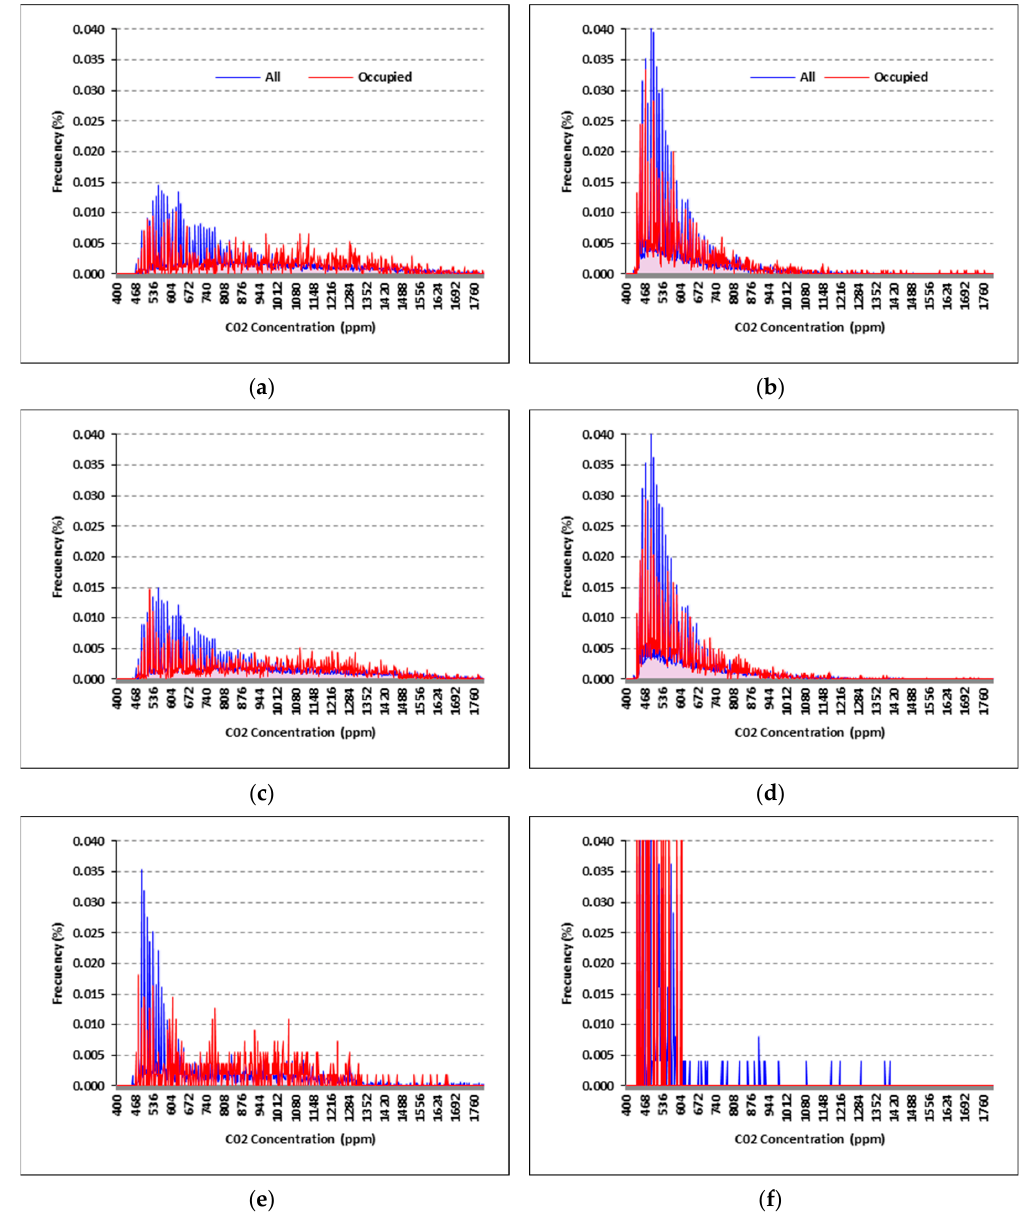
Figure 7. Histogram of CO 2 assuming that the house is positively occupied when there is water consumption. No clear breakpoint is identified from these figures even though the analysis distinguished between summer and winter and the different working levels of the mechanical ventilation system. CO 2 intervals every 2 ppm: ( a ) winter level 0; ( b ) summer level 0; ( c ) winter level 1; ( d ) summer level 1; ( e ) winter level 2; ( f ) summer level 2.